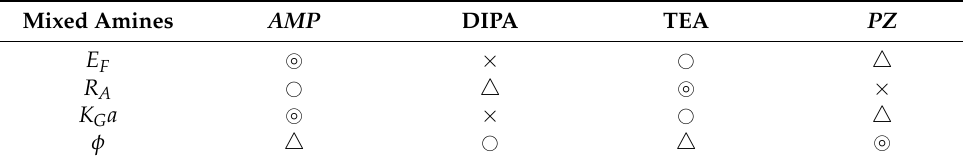
Figure 6. Bar charts of mixed amine for the comparison of various outcome data (respectively, NO.1 to NO.16). ( a ) Absorption efficiency; ( b ) Absorption rate; ( c ) Overall mass transfer coefficient; ( d ) Scrubbing factor. Table 8. Comparison of mixed amines in the outcome data.